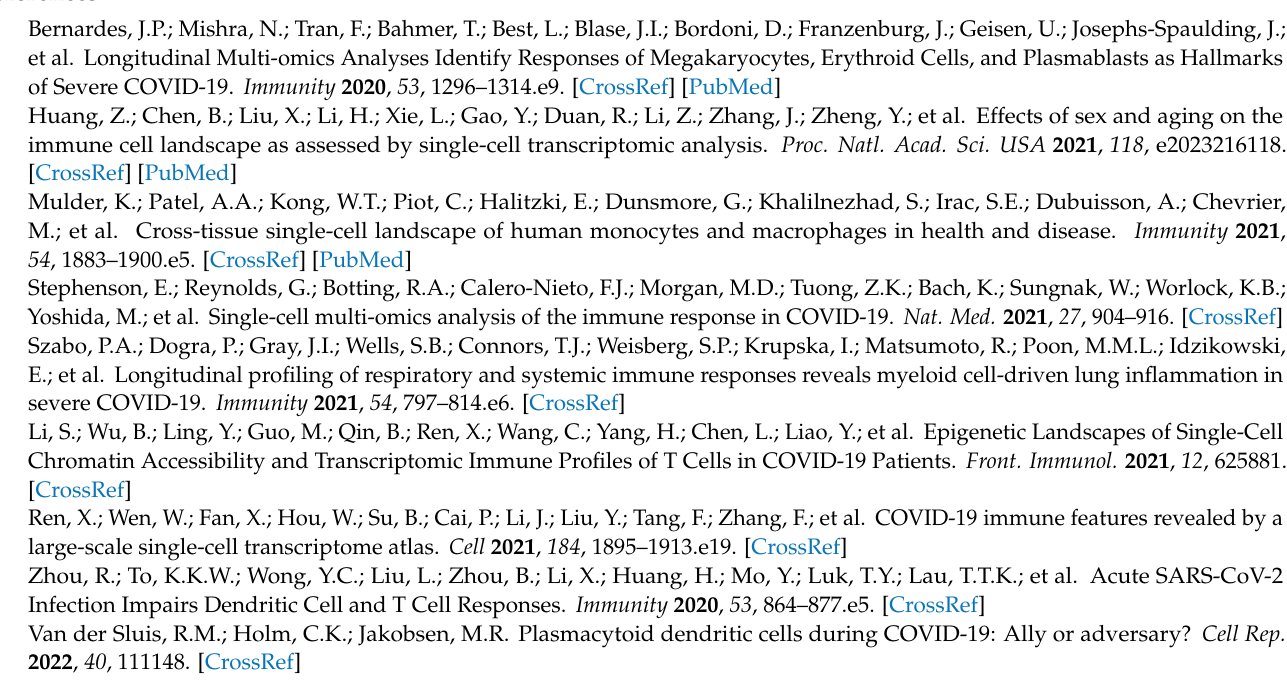
data integration approaches, Figure S3: Feature plots, Figure S4: Changes of the immune cell fractions in PBMC, Figure S5: Scatter plot, Figure S6: Module scores for gene signatures, Figure S7: Gene ontology terms, Figure S8: SCENIC UMAP splitted by severity, Figure S9: SCENIC UMAP plots for individually processed cohortes, Figure S10: Entire gene regulatory network, Figure S11: Cellchat differential interactions, Figure S12: Dotplot for communication molecules of the CCL-CXCL pathway, Figure S13: Ligand and receptors contrasting severe Delta and Wuhan-like cases based on the gene expression in monocytes, Table S1: Description of the in-house and public datasets used in the